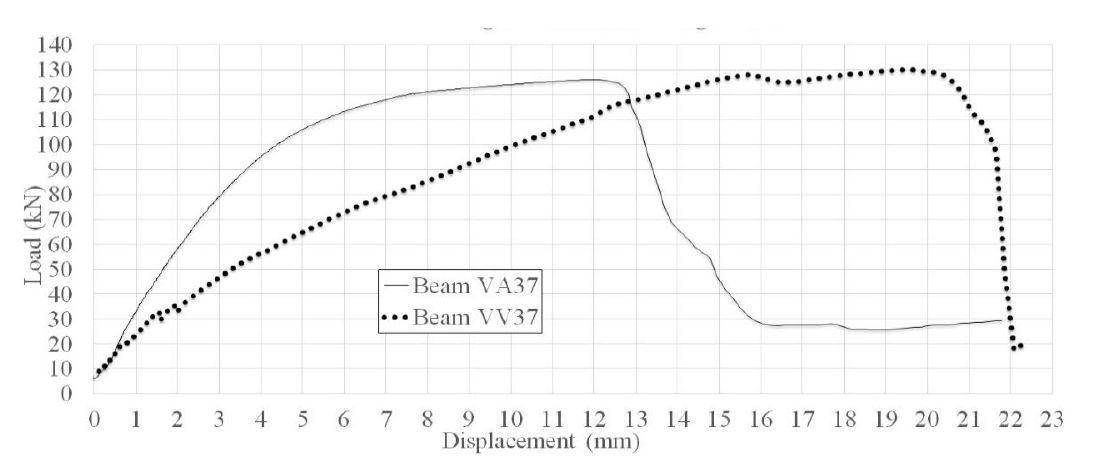
Figure 8. Load vs displacement curves of the 37.5 kN